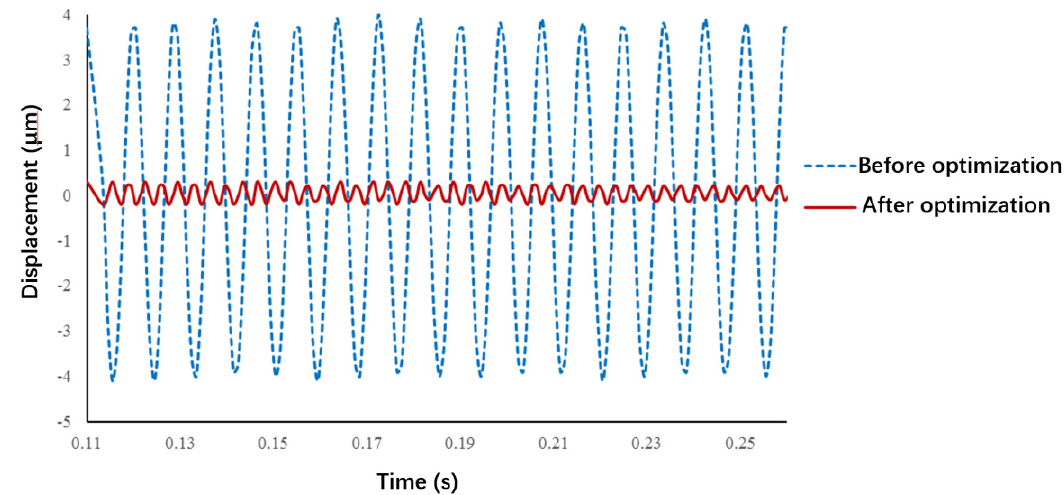
Figure 7. Vibration displacement response at the end of the moving finger.